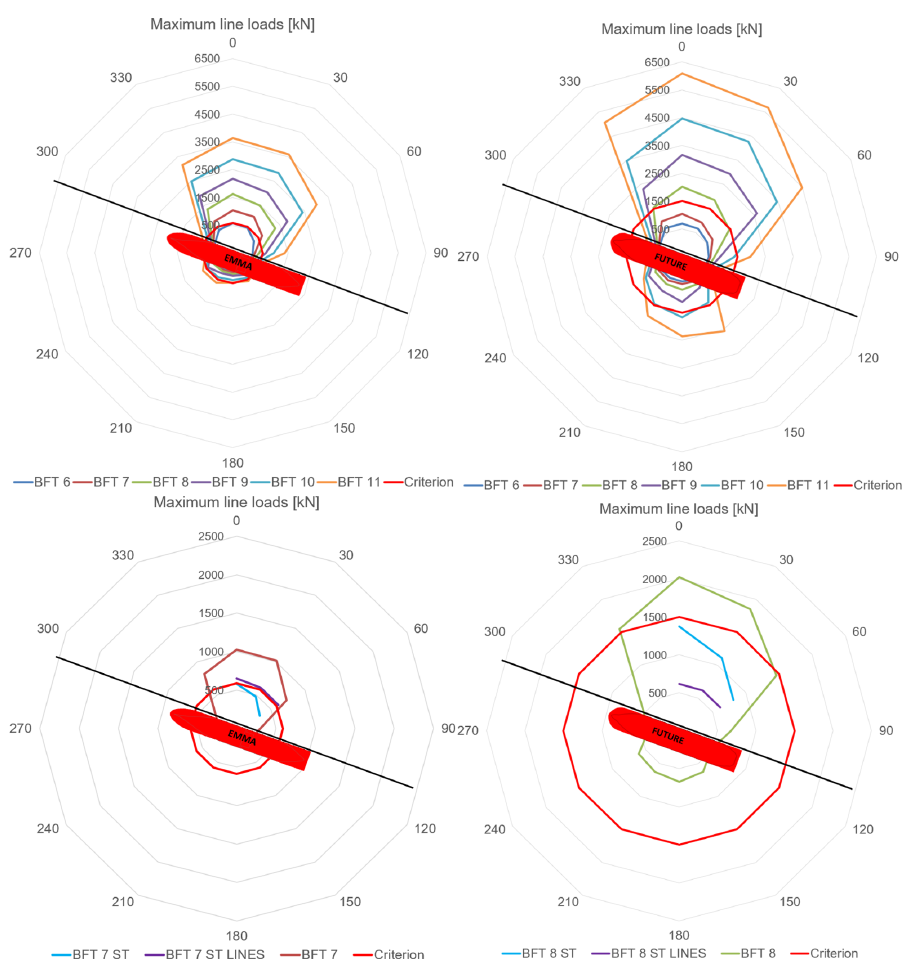
Figure 11. Maximum line loads results for dynamic wind conditions with and without ShoreTension ®